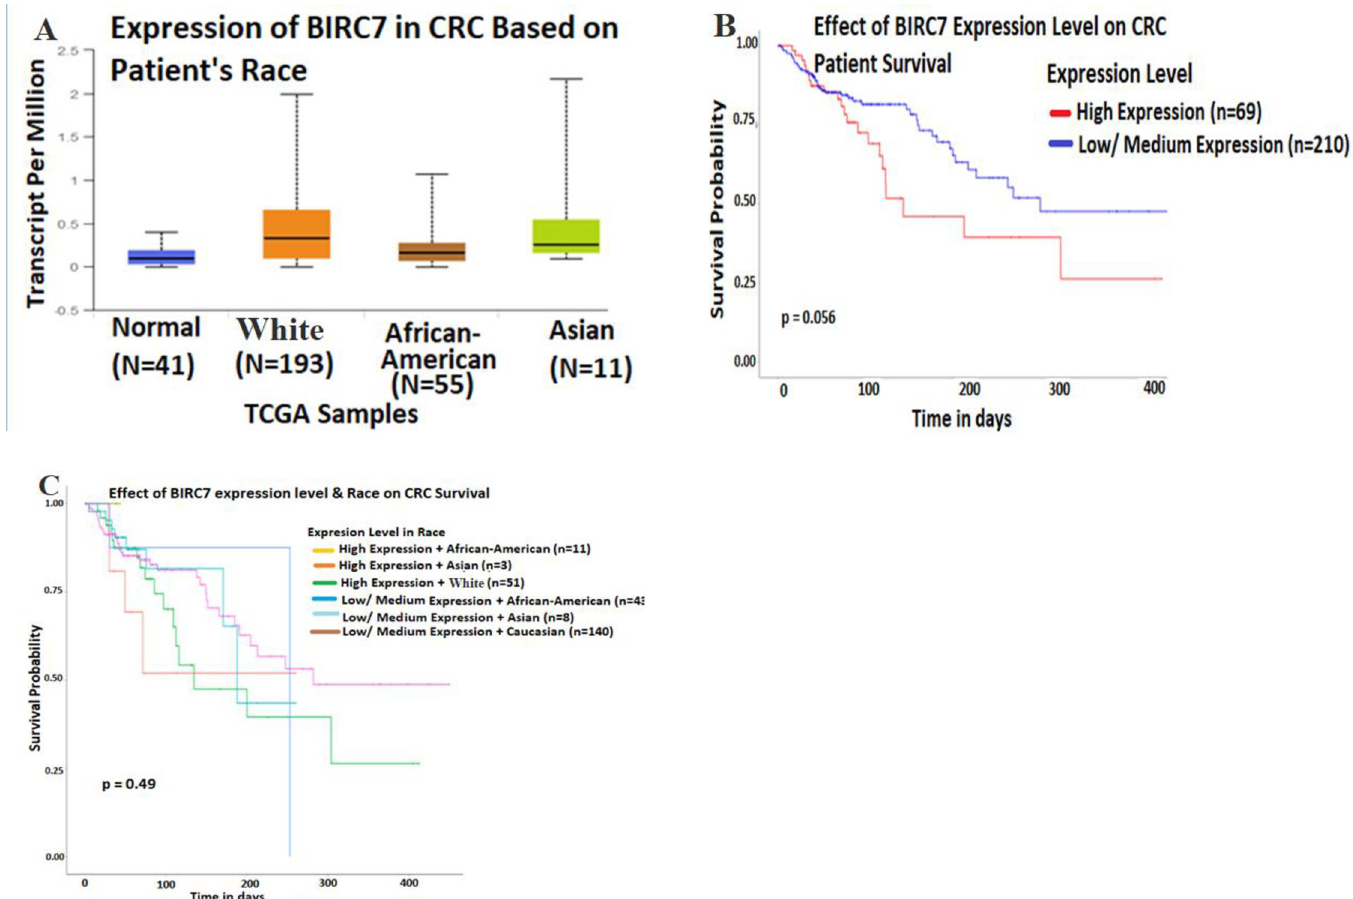
Fig 1. BIRC7/Livin expression pattern and survival probability in African-American compared with White and Asian race. A, Representative expression of BIRC7/ Livin in CRC based on patient race. B, Representative effect of BIRC7/Livin expression level on CRC patient survival. C, Representative effect of BIRC7/Livin expression level and race on CRC patient